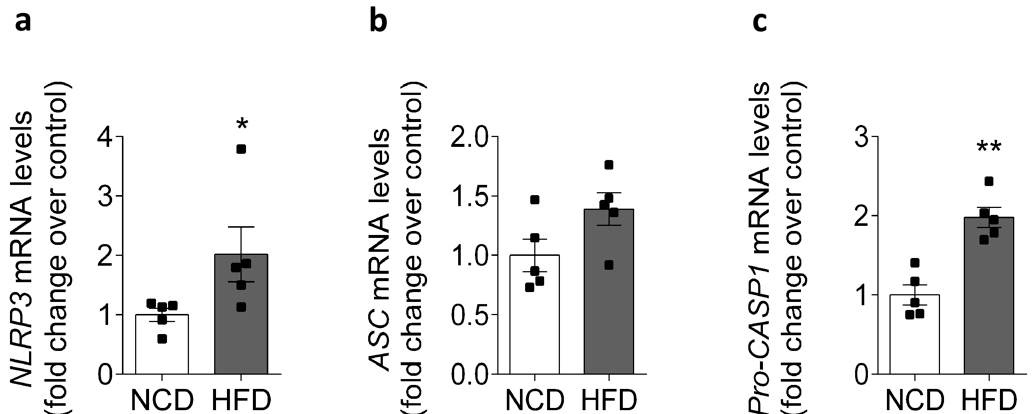
Figure 2. Expression of the NLRP3 inflammasome in the FDB muscle from NCD- and HFD-fed mice. FDB muscle was collected from NCD- or HFD-fed mice, and the mRNA level of the NLRP3 inflammasome was assessed by RT-qPCR and normalized to housekeeping gene Rplp0. The comparison of mRNA levels of ( a ) NLRP3, ( b ) ASC, and ( c ) pro-caspase-1. The expression of ASC did not change significantly after 8 weeks of an HFD. Data are shown as the mean ± SEM ( n = 5). * p < 0.05 and ** p < 0.01 vs. HFD, determined by Student’s t -test statistical analysis. NCD, normal control diet; HFD, high-fat diet.